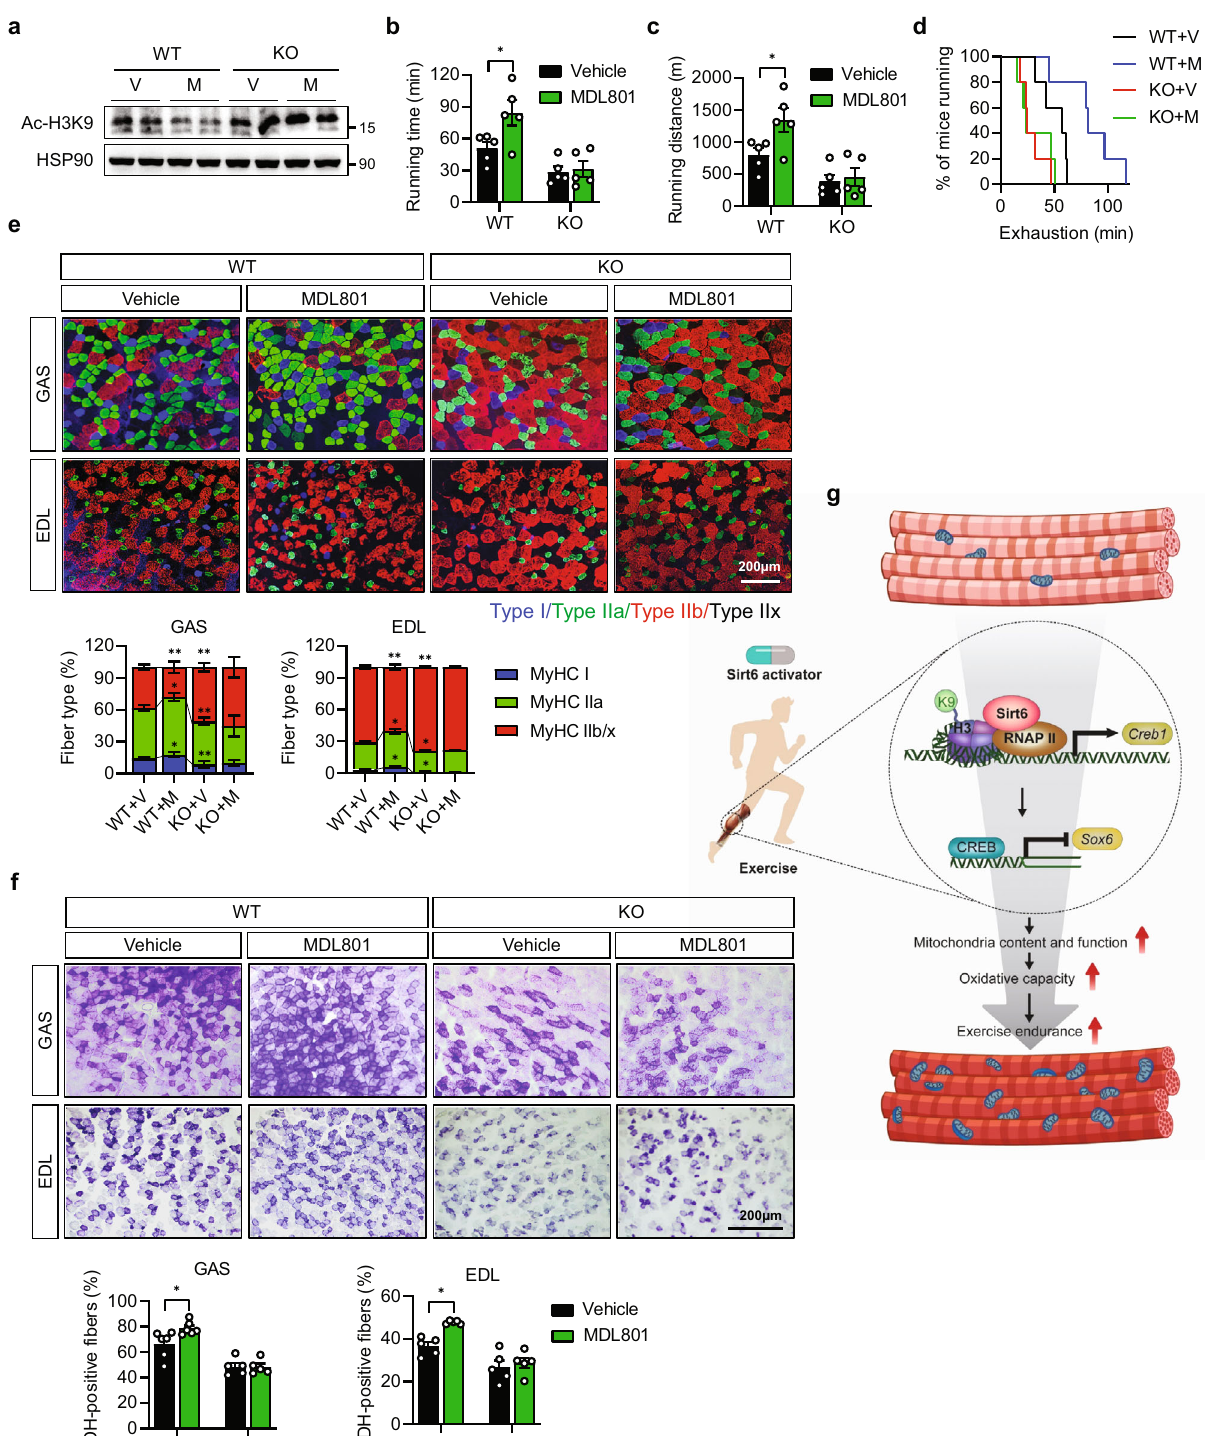
Fig. 6 Increase in endurance exercise performance in mice treated with Sirt6 activator. Twenty fi ve-week old WT and Sirt6 KO mice were treated with MDL801 (100 mg/kg) via oral gavage once a day for four weeks during treadmill exercise program. a Representative Western blot analysis of H3K9 acetylation in gastrocnemius muscles (GAS). b – d Running time, running distance, and time to exhaustion were compared between MDL801 (M)- and vehicle (V)-treated WT and Sirt6 KO mice ( n = 5). e Representative immuno fl uorescence staining for MyHC-I, MyHC-IIa and MyHC-IIb/x in GAS and extensor digitorum logus (EDL). Composition of each myo fi ber was quanti fi ed ( n = 5). Bar = 200 μ m. f Representative succinate dehydrogenase (SDH) staining and quanti fi cation of SDH-positive fi bers ( n = 5). Bar = 200 μ m. g Proposed model for Sirt6 regulation of myo fi ber composition. Values are mean ± SEM. Data are representative of at least three independent experiments. One-way ANOVA followed by Bonferroni ’ s post hoc analysis ( e ) and two- way ANOVA followed by Tukey ’ s post hoc analysis ( b , c , f ) were conducted for statistical analyses. * p < 0.05 and ** p < 0.01. Source data are provided as a Source Data fi